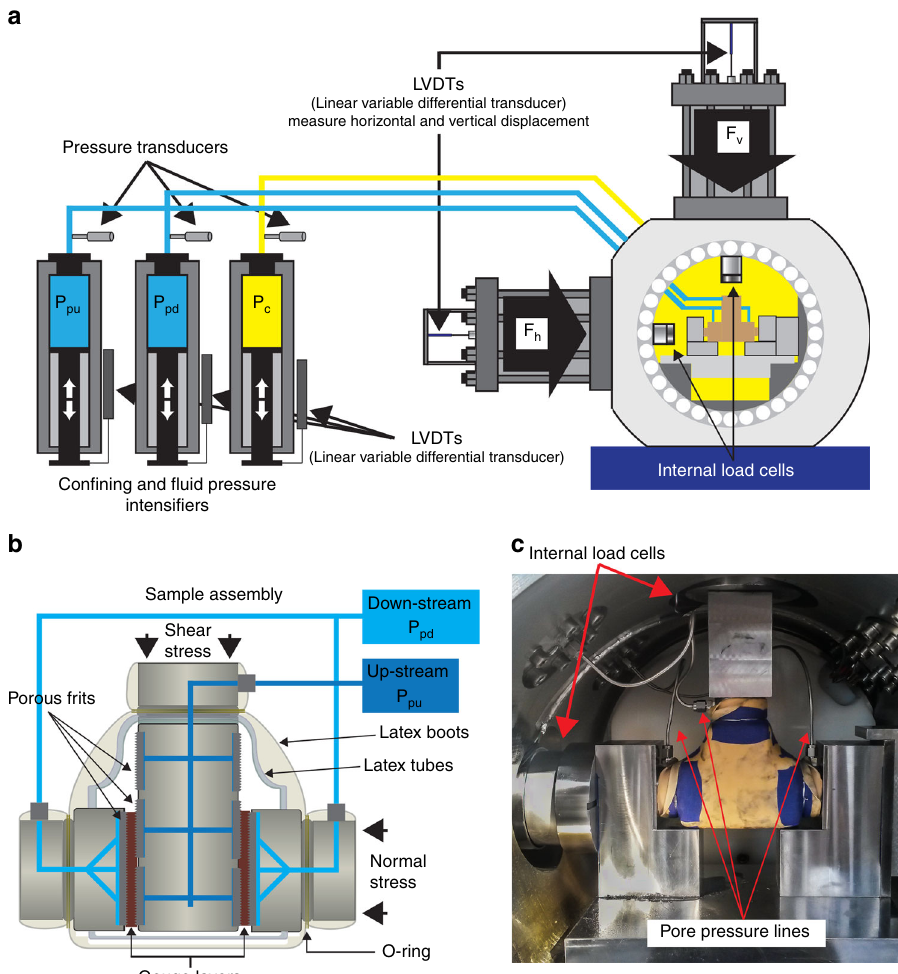
Fig. 7 Experimental apparatus: BRAVA. a Apparatus set-up, including the vessel, loading and measuring systems, and fl uid pressure intensi fi ers; b sample assembly for biaxial shear experiments; c internal view of the vessel with sample assembled for experiments with con fi ning